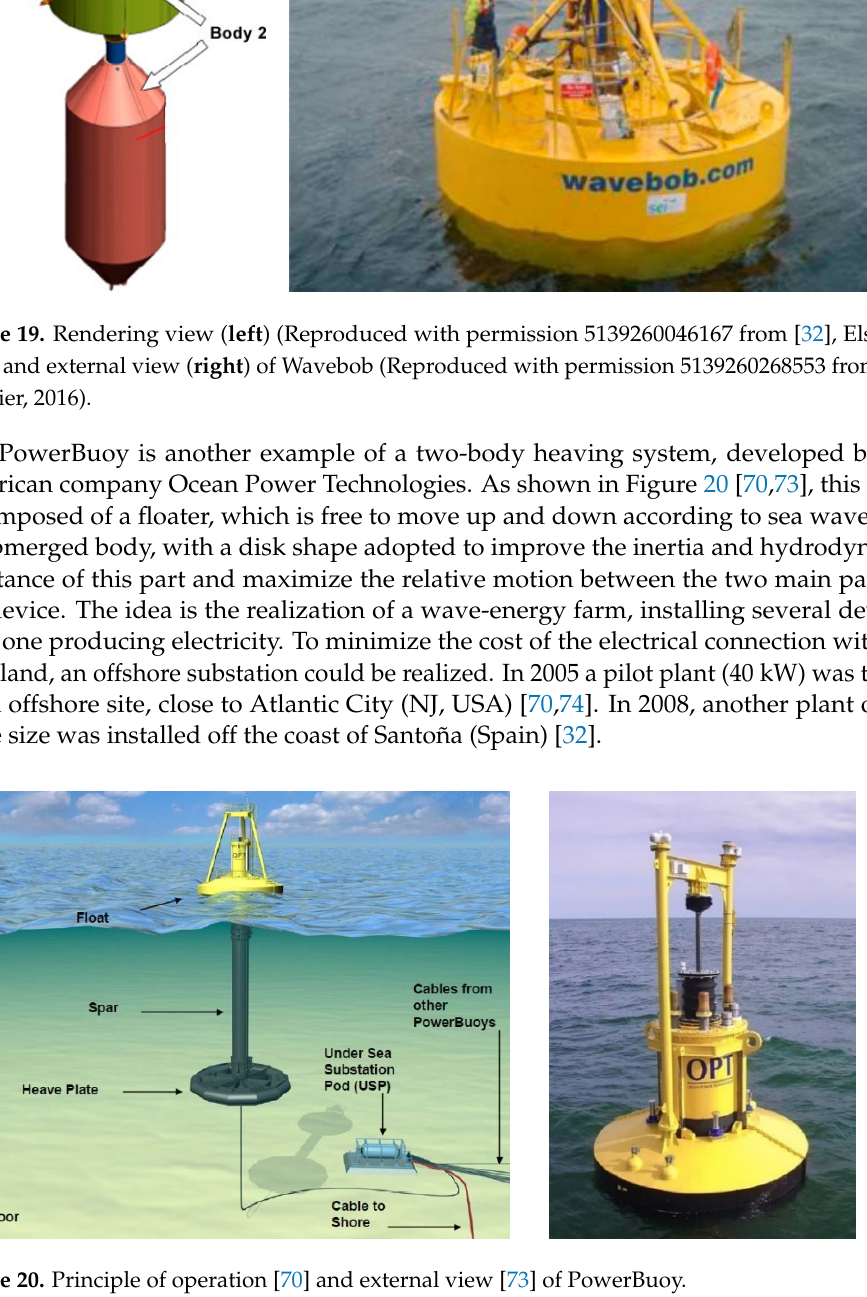
Figure 20. Principle of operation [70] and external view [73] of PowerBuoy.